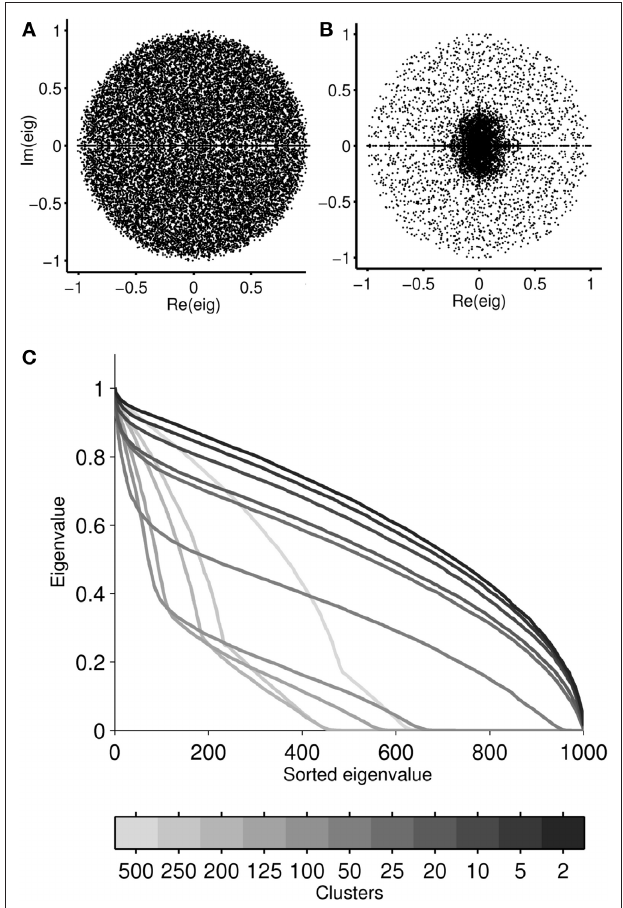
Figure 6 | eigenvalue spectra for 20 realizations of a reservoir with R = 1000 and 2 clusters (A) or 125 clusters (B). To visualize how the distribution of eigenvalues varied as clustering was increased, eigenvalues were sorted by their distance from the origin and plotted for r = 1 (C) , with each curve representing the mean of 20 realizations for each cluster configuration. Reservoirs with n > 25 have a non-uniform eigenvalue distribution with more than 30% of their eigenvalues concentrated at the origin.